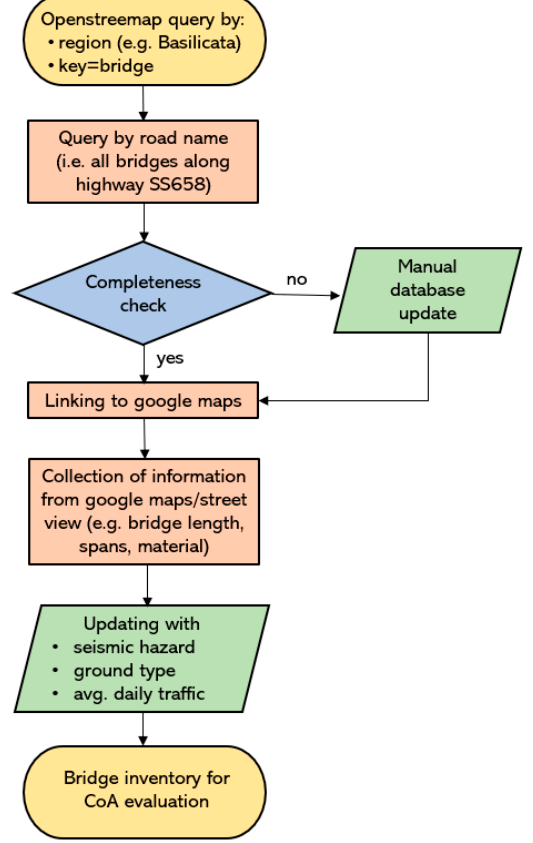
Figure 8. Procedure for bridge inventory.